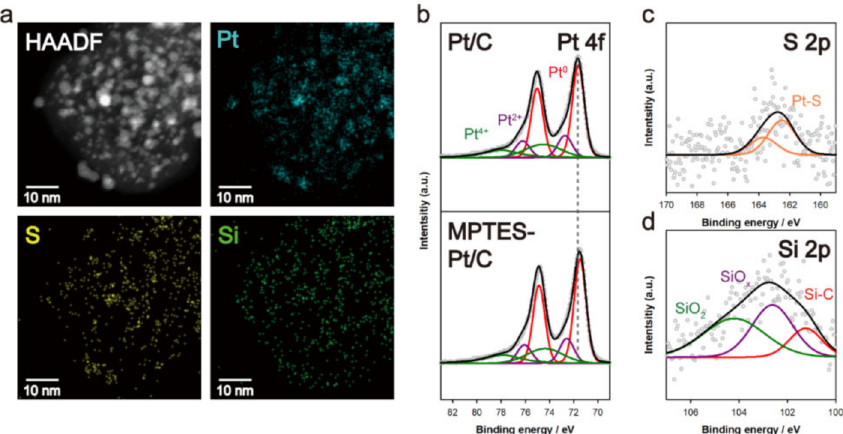
Figure 3. ( a ) Scanning transmission electron microscopy-energy dispersive X-ray spectroscopy (STEM-EDS), high-angle annular dark-field (HAADF) image, and Pt, S, and, Si elemental mapping images of 8.4-MPTES–Pt/C. ( b ) Pt 4f XPS spectra of Pt/C and 8.4-MPTES–Pt/C. ( c ) S 2p and ( d ) Si 2p XPS spectra of